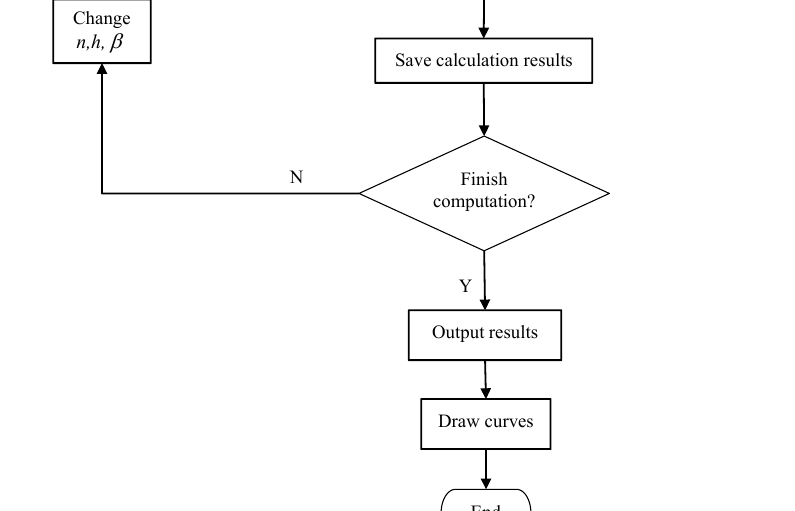
Figure 14. Calculation flow chart.